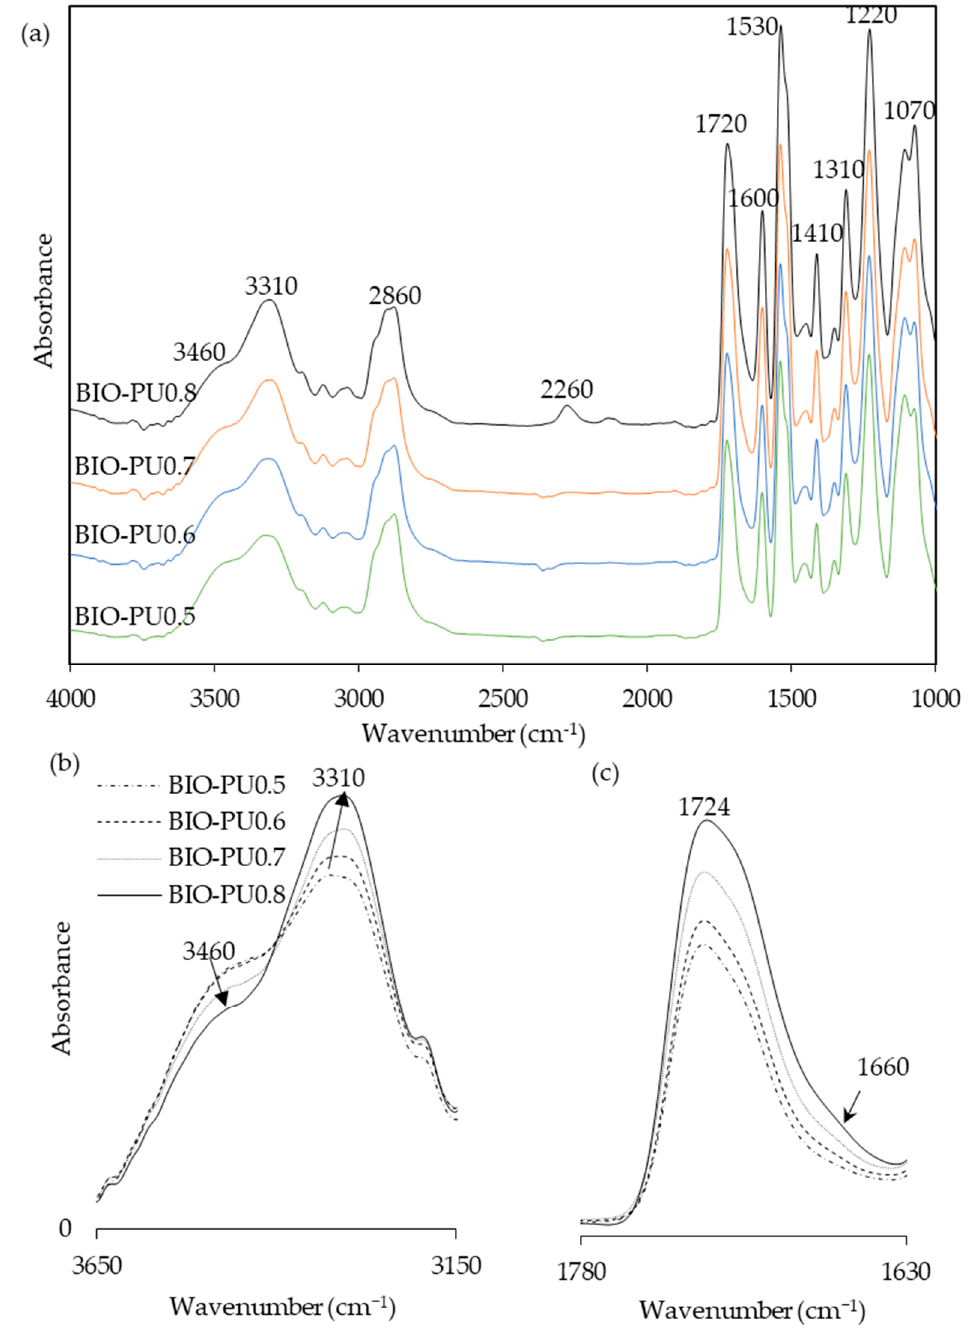
Figure 5. ( a ) FT-IR spectra, ( b ) NH-stretching region, and ( c ) amide region of BIO-PU films at different NCO/OH ratios.